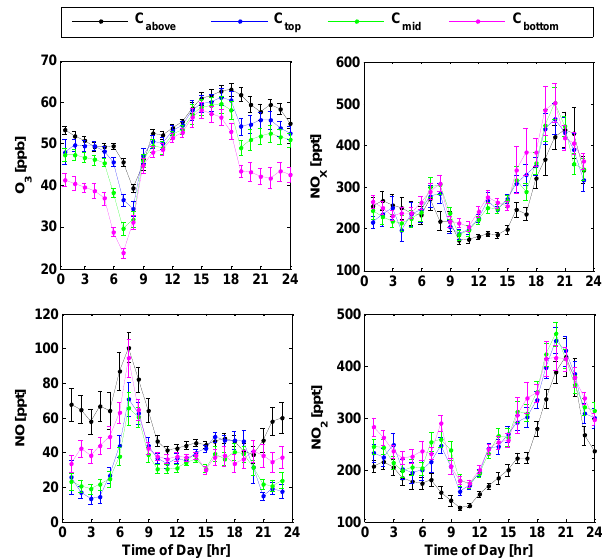
Figure 5. Diurnal patterns of O 3 (south tower), NO x , NO, and NO 2 . The data are one-hour mean values and the error bars represent the variation defined as the observed variability (± 1 σ) divided by square root of the number of measurements in that time bin. Colors represent the measurement heights: above canopy (18 m) in black, top canopy (9 m) in blue, middle canopy (5 m) in green, and forest floor (1.5 m for O 3 and 0.5 m for NO and NO 2 ) in magenta.